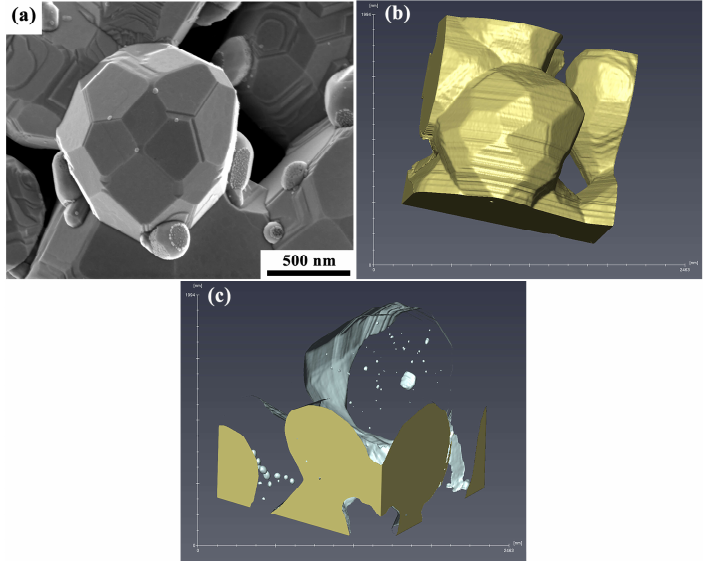
Figure 10. 3D reconstruction of a W particle from scandate cathode #2, generated by FIB serial sectioning and imaging in the SEM. ( a ) Secondary electron SEM micrograph of the selected W particle, ( b ) reconstructed tomogram, and ( c ) spatial distribution of Sc/Sc 2 O 3 inside the W particle. Note that the viewing direction of image ( c ) is rotated with respect to that of images ( a , b